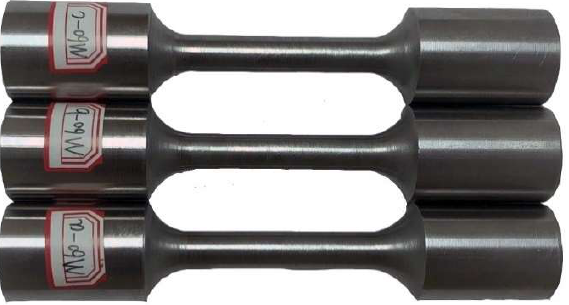
Figure 5. The standard specimens of the M60 high-strength bolt for tensile tests. Table 1. The M60 high-strength bolt’s chemical composition [23]. Element